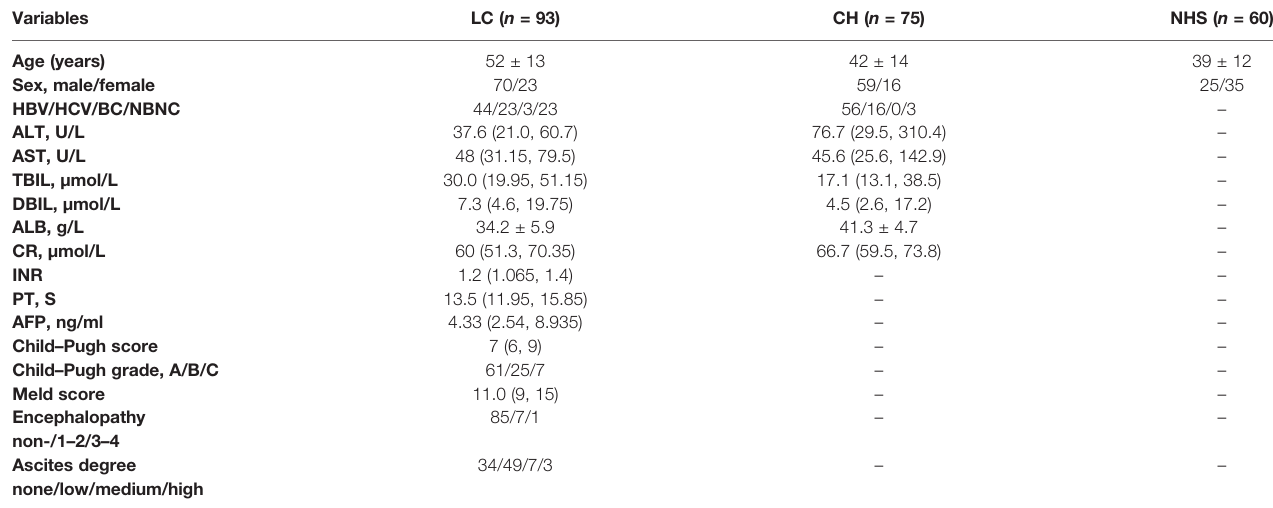
TABLE 1 | Baseline characteristics of patients in the LC, CH, and NHS groups.